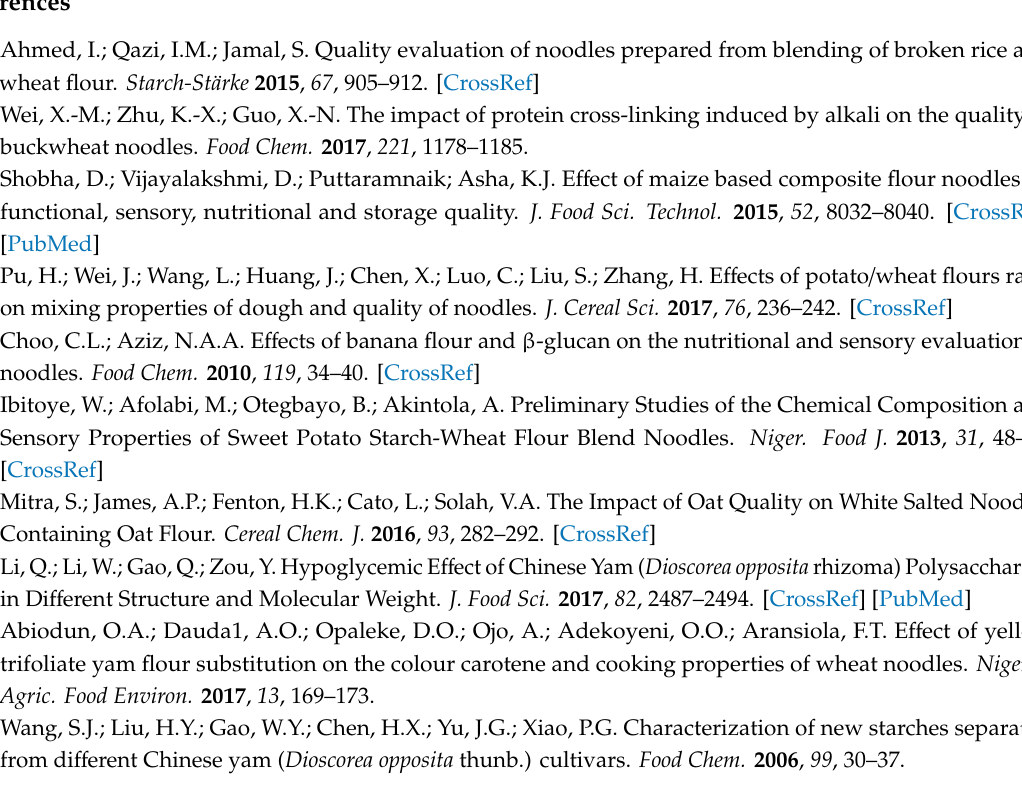
Figure S1: Di ff erential scanning calorimetry (DSC) traces of the gelatinization parameters of control wheat flour (W) and yam powder (Y) and wheat flour-yam powder mixtures at 10% to